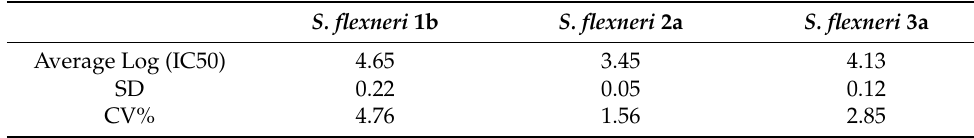
Table 1. Average LogIC50, SD and CV% of GVGH41148 serum against each of the three S. flexneri serotypes